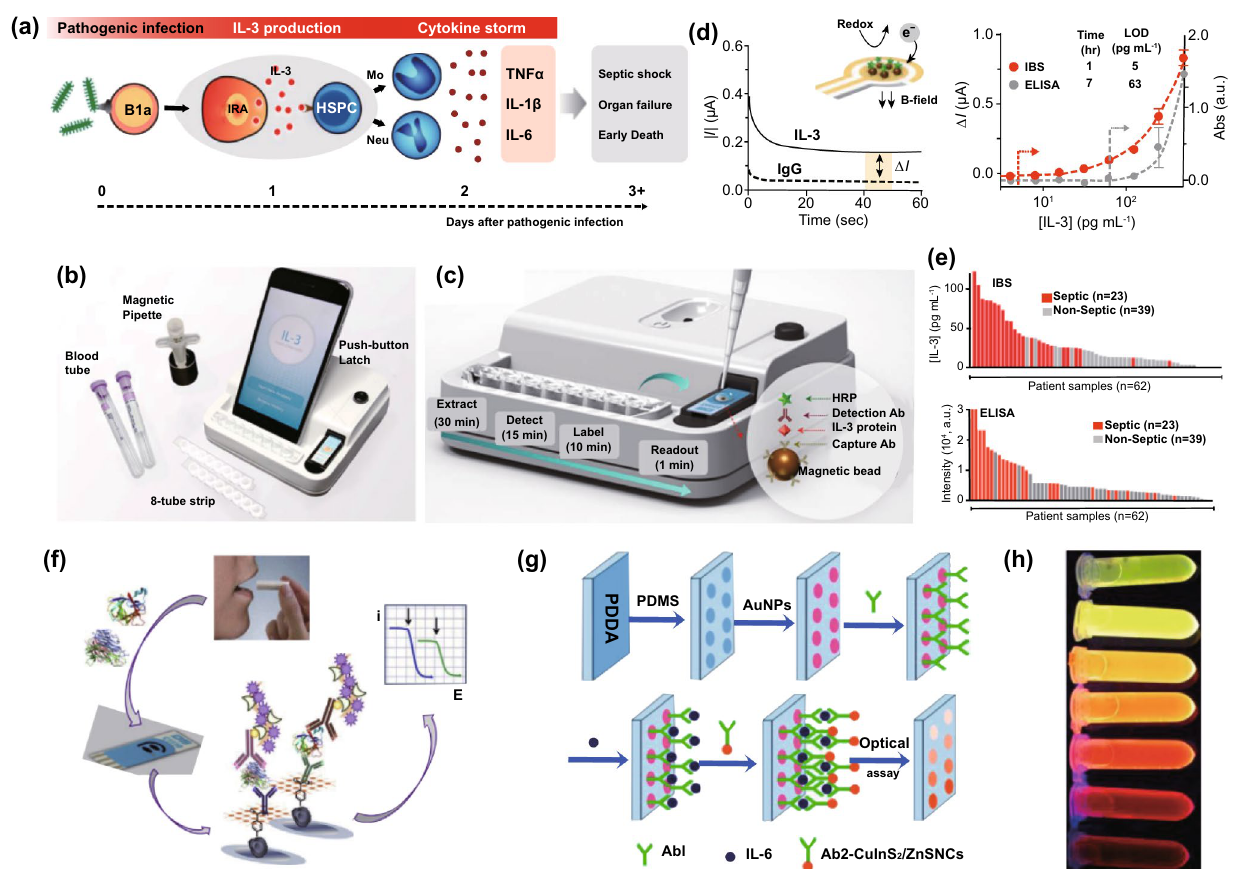
Fig. 10 Integrated biosensor for rapid point-of-care sepsis diagnosis by detecting IL-3. a IL-3-mediated mechanism of sepsis. b Photograph of the whole integrated biosensor system. c Detection steps and principle of the integrated biosensor for IL-3 detection. d Electrical currents are generated on or near the electrode via TMB redox reaction catalyzed by HRP-coated magnetic beads, varying concentrations of IL-3-containing human plasma were assayed by IBS and ELISA. e Samples from septic ( n = 23) and nonseptic patients ( n = 39) were analyzed by integrated biosensor and ELISA. Reproduced with permission from Ref. [163]. Copyright 2018 American Chemical Society. f Dual screen-printed elec- trodes modified with functionalized double-walled carbon nanotubes for the simultaneous detection of IL-1β and TNF-α in serum and saliva. Reproduced with permission from Ref. [160]. Copyright 2017 Elsevier. Color-tunable CuInS 2 /ZnS nanocrystals for IL-6 detection. g Schematic mechanism of the proposed nanosensor for IL-6 detection. h Photographs of CuInS 2 /ZnS NCs with various ratios of Cu/In (bottom 3:4, 1:2, 3:8, 1:3, 1:4, 1:5, and 1:10 top) under excitation at 365 nm UV. Reproduced with permission from Ref. [157]. Copyright 2013 American Chemical